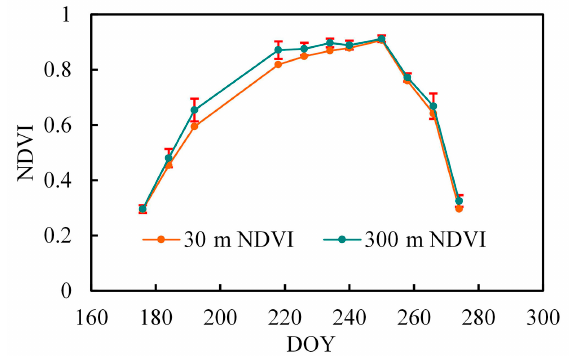
Figure 10. Landsat NDVI data of different resolutions at the US-Ne2 site in 2004. Table 8. Accuracy of CCC retrieval for soybean crops using three approaches with MERIS satel- lite